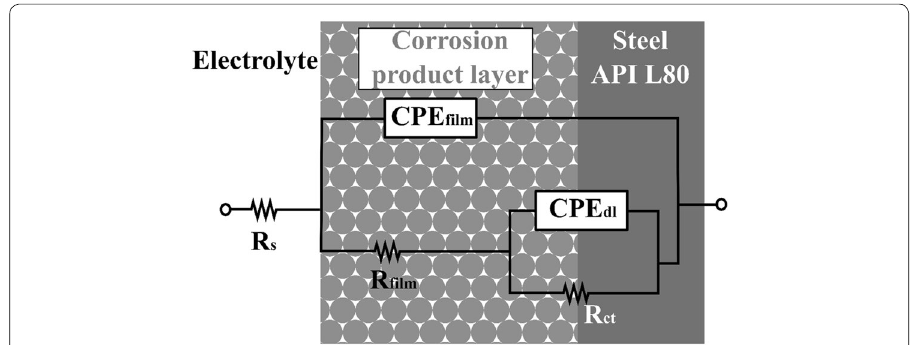
Fig. 8 Equivalent circuit R ( Q ( R ( QR ))), where the electrolyte, the porous corrosion product layer, and the steel sample API L80 are